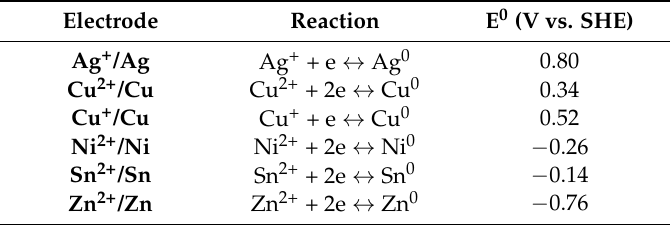
Table 6. The standard reduction electrode potential of the metal ions present in the solution at 25 ◦